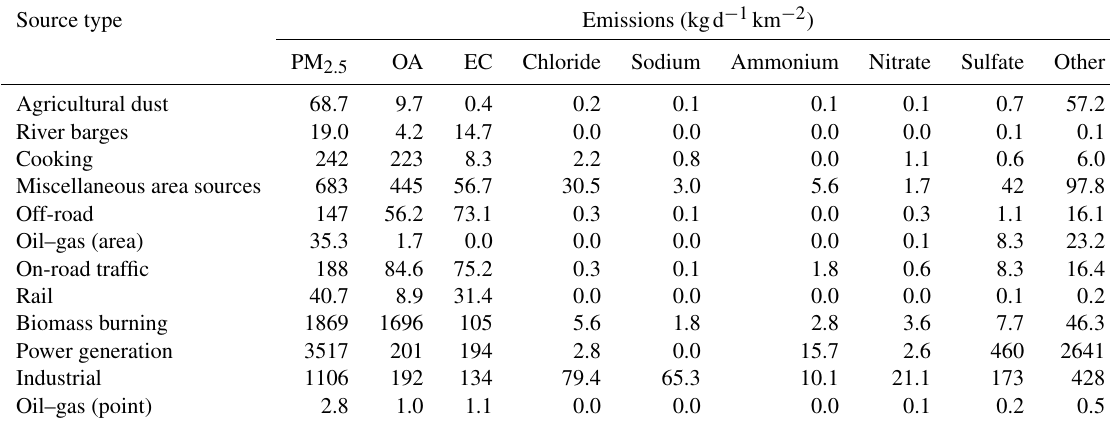
Table 1. PM 2 . 5 emissions by source for the 1 × 1km Pittsburgh domain (February 2017). Source type